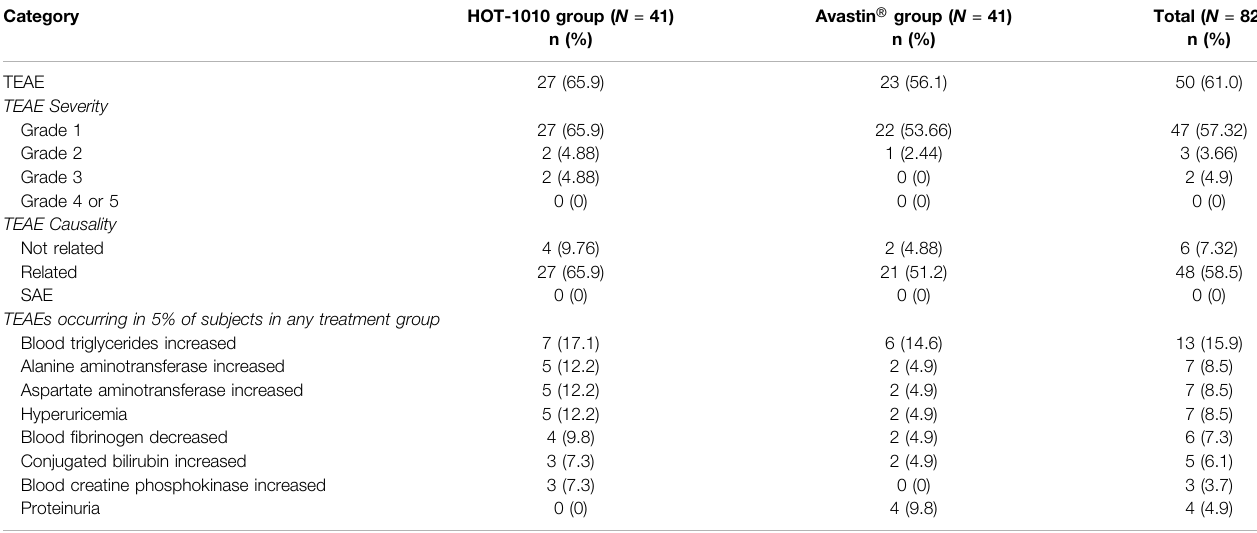
TABLE 4 | Summary of treatment-emergent adverse